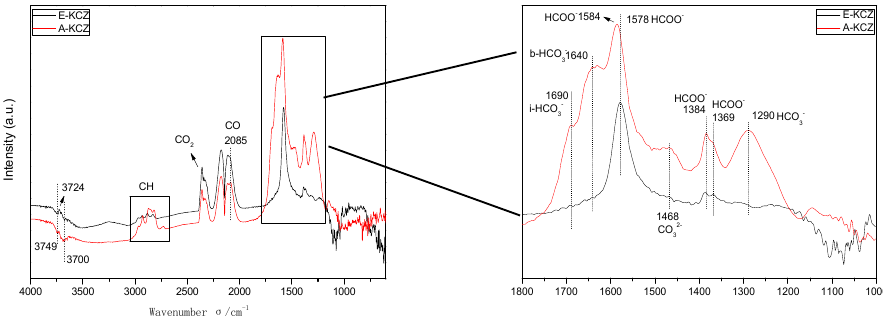
Figure 6. Infrared spectra of E, A-KCZ catalysts with CO adsorption.